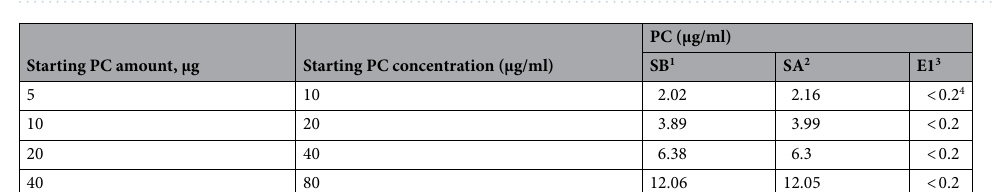
Table 2. PC quantification in the supernatant of superparamagnetic beads loaded with HS02-52G aptamer before and after capturing process, the same as the first elution fraction. 1 SB, supernatant before capturing ; 2 SA, supernatant after capturing ; 3 E1, first elution fraction ; 4 according to the lowest dilution factor needed for elution fractions, 0.2 µg/ml is the minimum detectable PC concentration which can be detected.